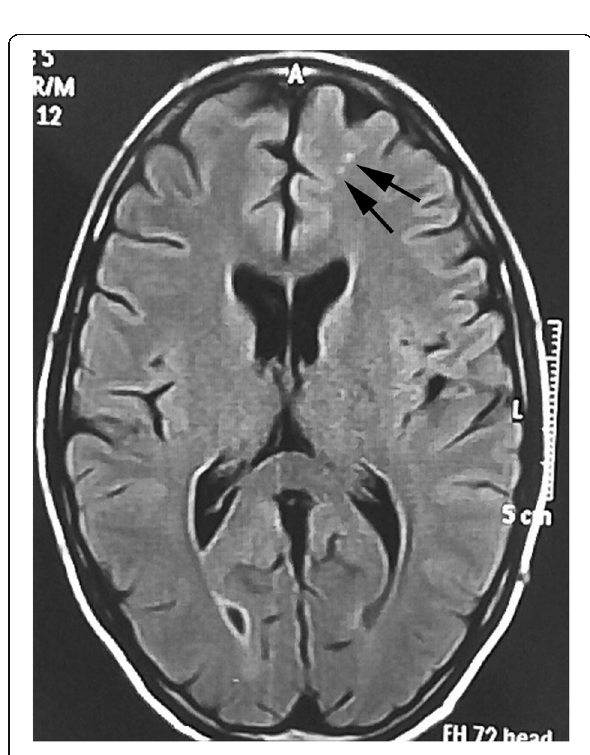
Fig. 2 25-year-old female patient, not known to have any chronic illness, presented with migraine without aura for 6-year duration of grade II severity, not responding to medical treatment. Axial FLAIR MRI image shows two left frontal white matter hyperintense lesions